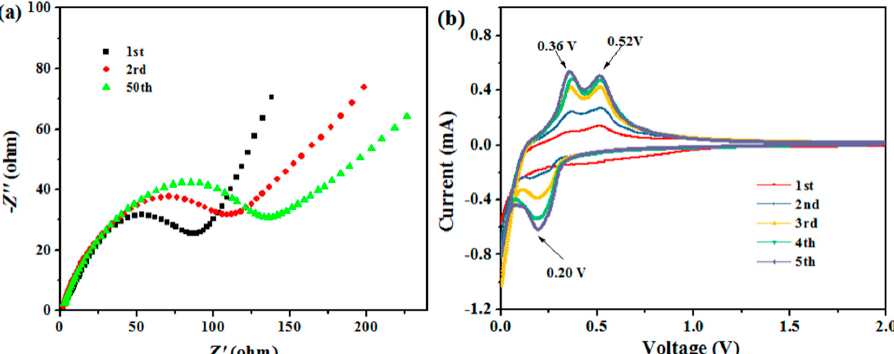
Figure 9. Rate capability of the silicon-carbon nanocomposite at different current densities between 0.01 and 1.5 V. 4. Conclusions In summary, the silicon-carbon nanocomposite was facilely synthesized by the one-step magnetoelectric plasma pyrolysis method. The effects of the ratio of silane, methane, and hydrogen on the properties of the composites were investigated in this paper. Under the optimized ratio of hydrogen/silane/methane (1:1:3), the silicon-carbon nanocomposite is composed of tremelliform carbon nanosheets and spherical Si nanoparticles and without SiO 2 and SiC according to the XRD and Raman spectroscopy analysis. As anodes for LIBs, the tremelliform carbon nanosheets of silicon- carbon nanocomposite can efficiently alleviate the volume changes of Si nanoparticles during the